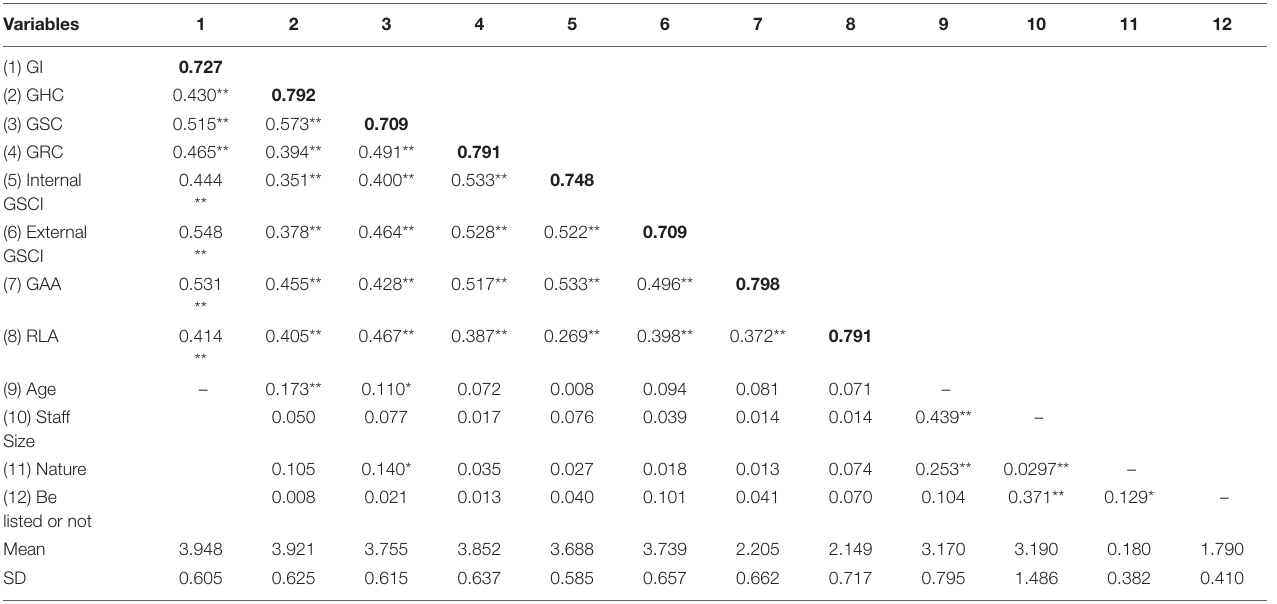
TABLE 2 | Descriptive statistics and correlation matrix. Variables